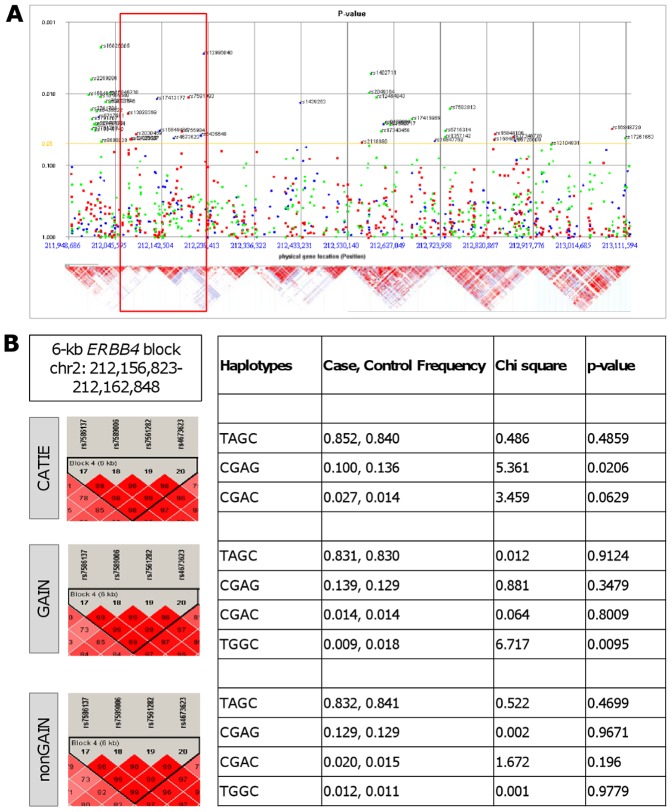
Validation of previously identified and identification of novel haplotypes of ERBB4 in schizophrenia GWAS datasets.
A.
ERBB4 polymorphims in three schizophrenia GWAS datasets are illustrated in GWADview software. SNPs are plotted by their location on the y-axis and by their genomic position on the x-axis. Blue represents CATIE, red GAIN and green nonGAIN. The lower panel shows haplotype blocks of this region in Hapmap CEU population. B. LD plots of ERBB4 with the most significant haplotypes in the region from 212,100,000 bp to 212,200,000 bp. Cut-off value for Hardy-Weinberg is 0.05 and for minor allele frequencies 0.001.